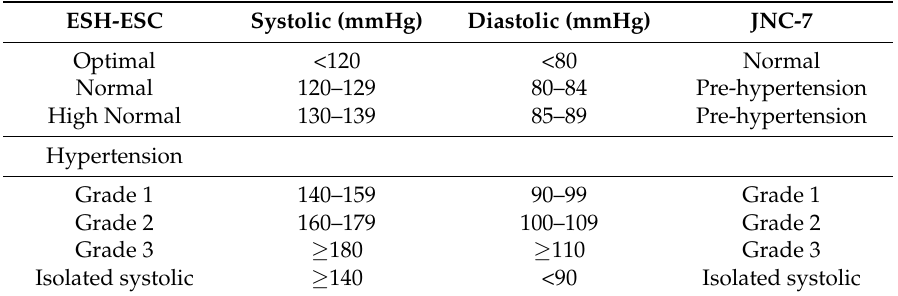
Table 1. Classification of blood pressure. Source: Latin American Guidelines for Arterial Hypertension. ESH-ESC Systolic (mmHg) Diastolic (mmHg) JNC-7 Optimal <120 <80 Normal Normal 120–129